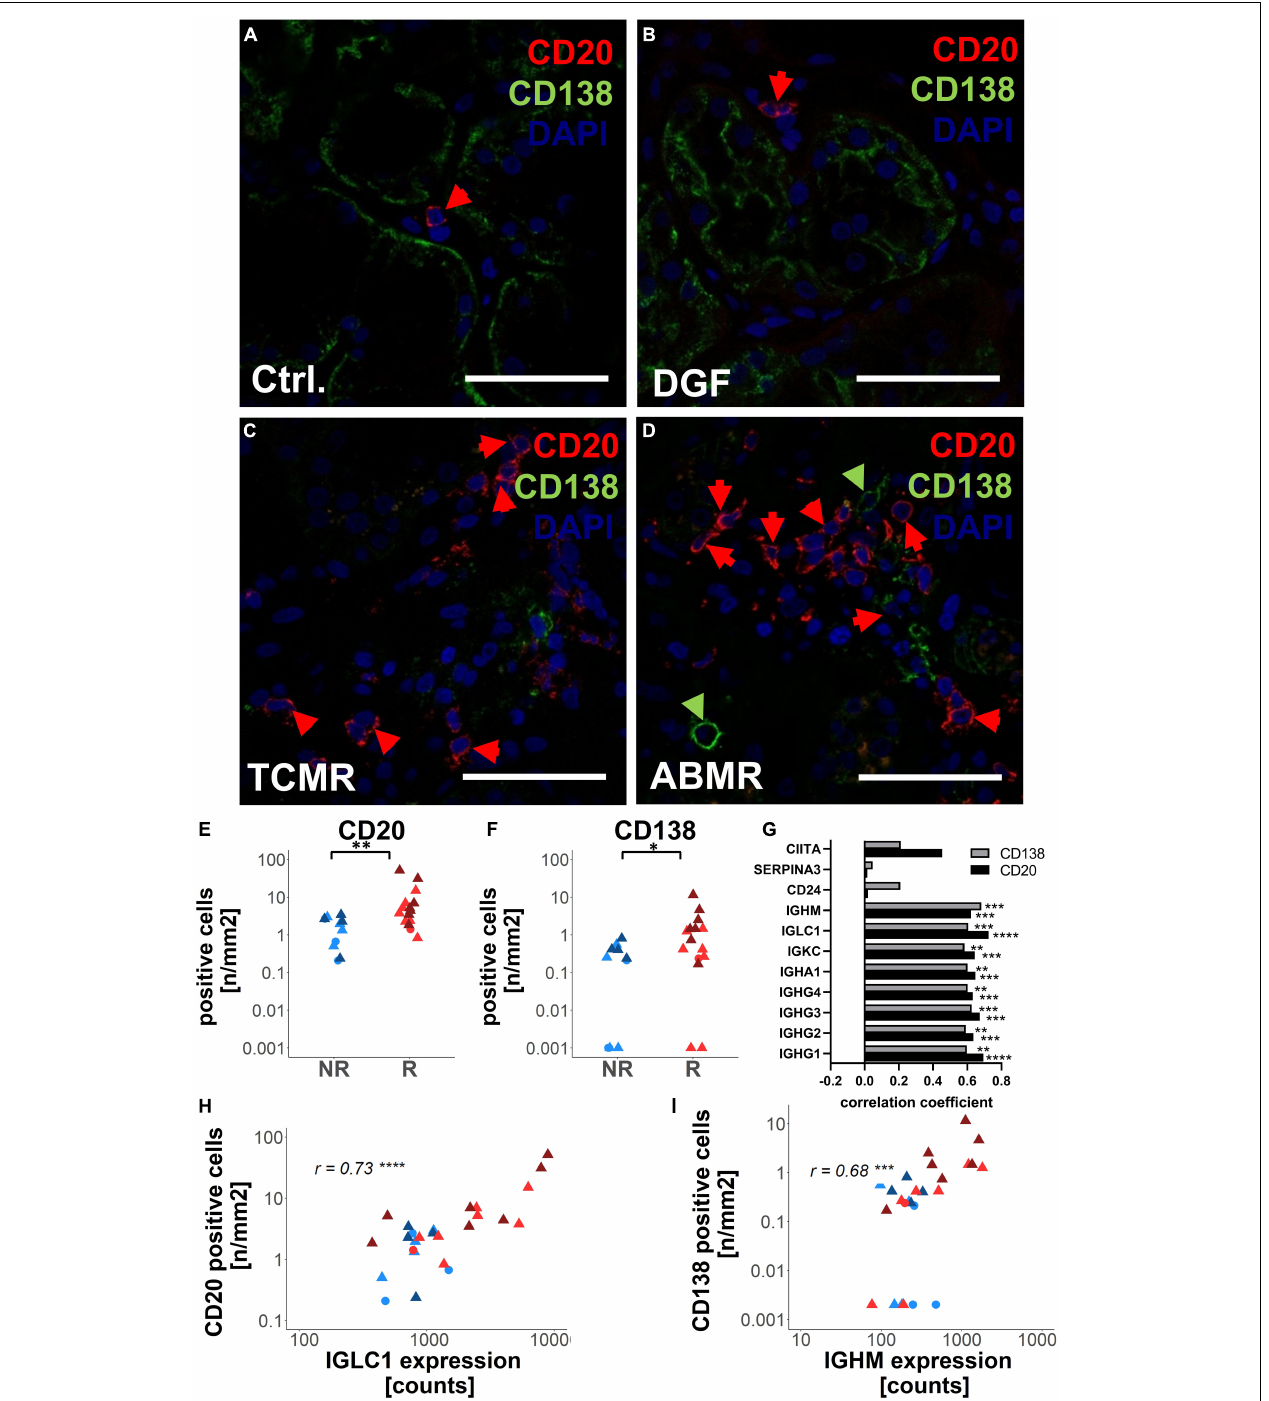
FIGURE 5 | Analysis of antibody-producing cells in zero-time biopsies with the different later outcomes. CD20-positive B-cells and CD138-positive plasma cells were analyzed using immunofluorescence microscopy in zero-time biopsies of Ctrl (A) , delayed graft function (DGF) (B) , T-cell mediated rejection (TCMR) (C) , and antibody-mediated rejection (ABMR) (D) . Examples of CD20-positive cells were marked by red arrows and CD138-positive cells by green arrows. The numbers of CD20-positive cells (E) and CD138-positive (F) per biopsy area were shown in biopsies that later on developed rejection (R) or no rejection (NR). Correlation between the expression levels of differentially expressed genes between rejection and no rejection was shown (G) . Histograms for correlation of the number of CD20-positive cells with the gene expression level of IGLC1 (H) and numbers of CD138-positive cells with gene expression levels of IGHM (I) in zero-time biopsies were shown. Scale bar represents 50 µ m; r: Spearman’s rank correlation coefficient; ∗ p < 0.05; ** p < 0.01; *** p < 0.001; **** p < 0.0001.